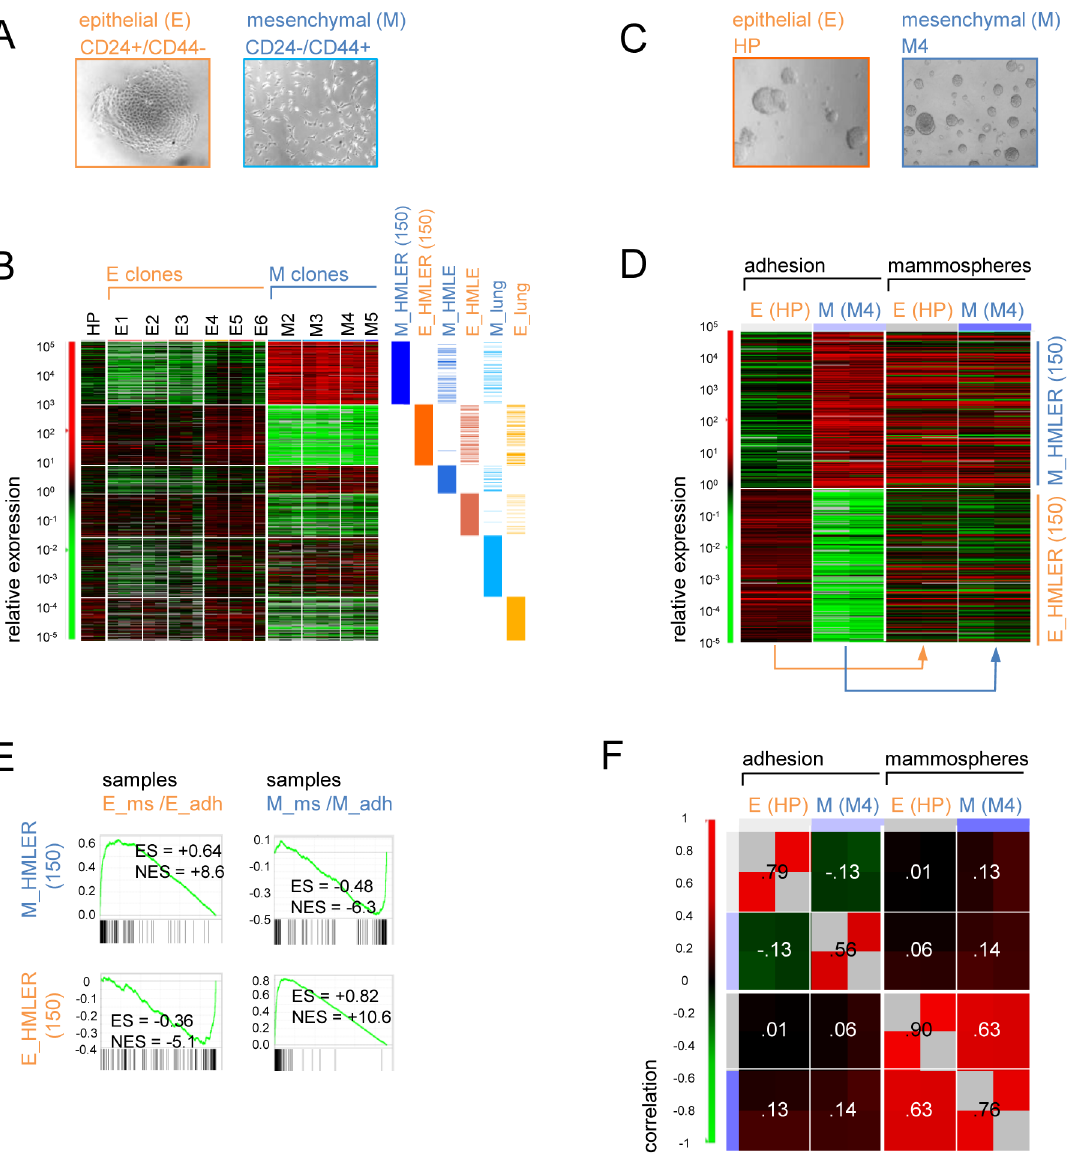
Fig 1. In mammospheres E and M cell lines converge to an intermediate E/M gene expression state. (A) Phase-contrast (20x) images showing a typical HMLER CD24+/CD44-(E) clone and a typical HMLER CD24-/CD44+(M) clone. Orange color refers to epithelial cells, and blue color to mesenchymal cells throughout manuscript. (B) Heat map of the E and M-specific gene expression defined as the 150 most extreme differentially expressed genes between morphological E clones and M clones (E_HMLER (150), and M_HMLER (150), S1 Table) in different HMLER cell-lines. RNA for gene expression arrays shown was isolated from different cell line passages. Gene expression data were relative-normalized towards the intermediate expression between E and M clones. Overlap with other E and M gene sets from different cell-types (HMLE cells and lung cancer) is shown on the right. (C) Phase-contrast (20x) images showing mammospheres grown in suspension of epithelial HP cells and the mesenchymal M4 clone. (D) Heat map of E and M-specific genes expressed in HP(E) and M4(M) cells when grown under adhesion and suspension mammospheres conditions. Normalization of gene expression was as in B, biological duplicate arrays are shown. (E) GSEA of gene expression dynamics between cells grown in adhesion versus suspension from (D), assessed for the E- and M-specific genes. (Normalized) Enrichment Scores (NES and ES) were based on duplicate arrays, had a false discovery rate q-value of < 0.0001 and a family wise p-value < 0.01 (S3 Table).(F) Pearson correlation coefficient between whole transcriptomes from (D) for global profiles. Numbers in heatmap represent the correlation average.